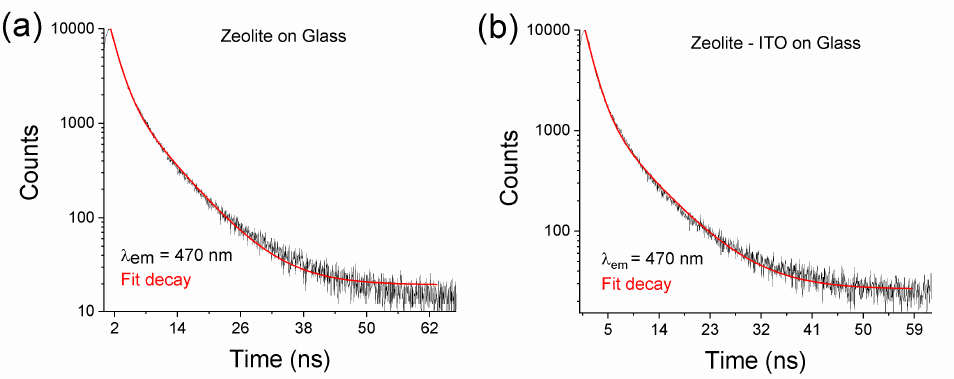
Figure 8. Fluorescence decays of ( a ) the zeolite / glass and ( b ) zeolite / ITO / glass ( λ Ex = 370 nm, λ Em = 470 nm).